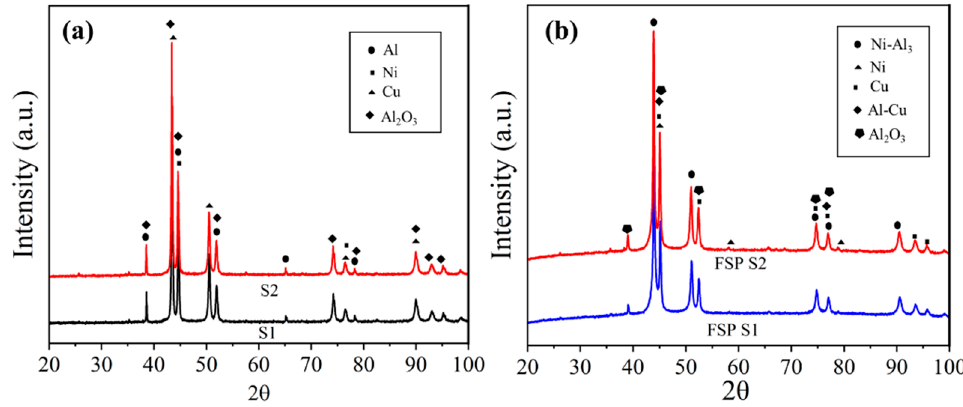
Figure 9. ( a ) XRD spectra of as ‐ sprayed S1 and S2 coating and ( b ) of the friction stir processed FSP ‐ S1 and FSP ‐ S2 coatings.